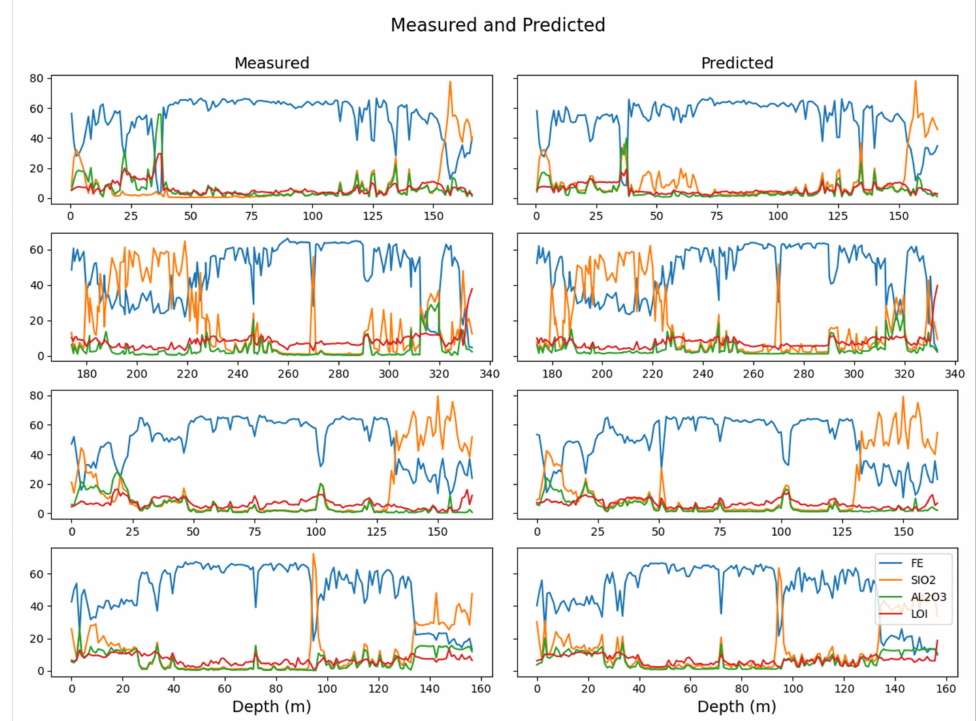
Figure 6. The measured and predicted downhole values for Fe, SiO 2 , Al 2 O 3 and LOI of four randomly selected drillcore where the length of the drillcore comprised greater than 150 entries. The other whole-rock geochemistry parameters are not shown due to the values being comprised of background only which only appear as singular valued traces along y = 0. Overall a good correspondence between the predicted and measured values is observed with generally minor deviations